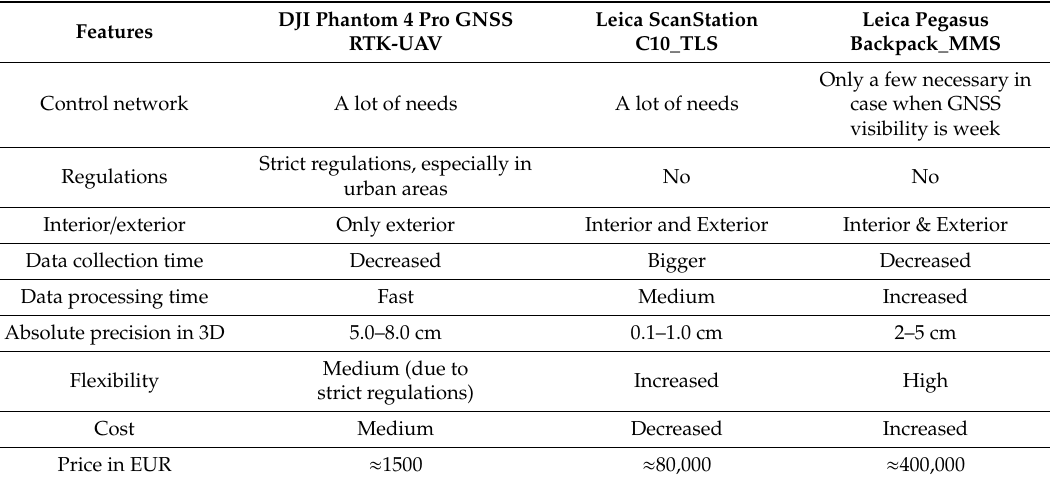
Table 2. Comparisons between UAV, TLS, and MMS.